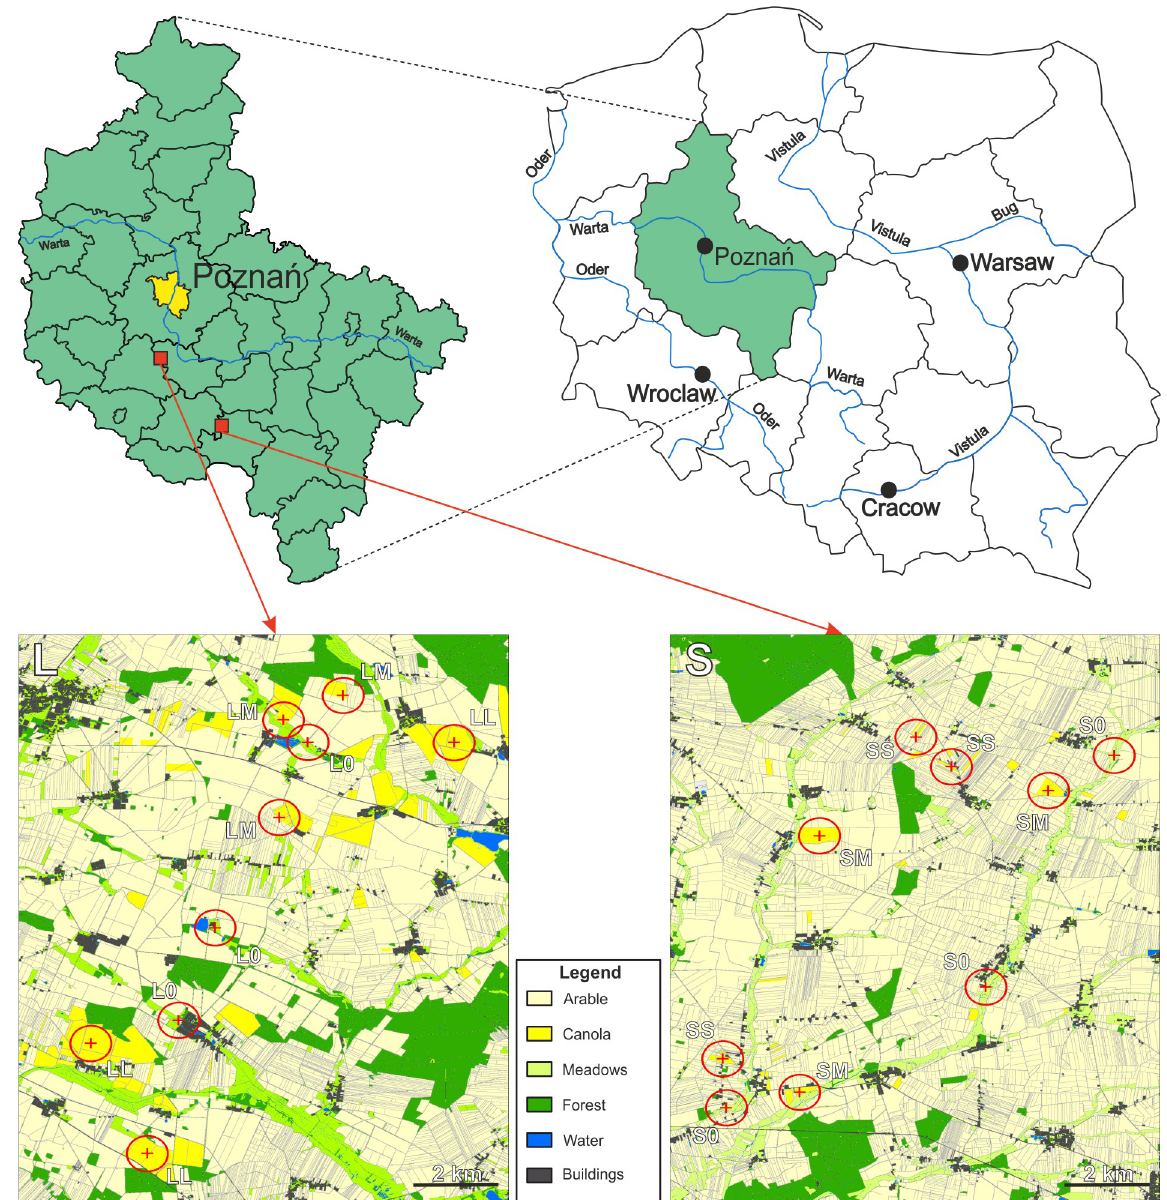
Fig 1. Location of the study landscapes and sites. Upper right, administrative division of Poland into provinces. In green–Wielkopolska province. Upper left–administrative division of Wielkopolska with the capital of the region [Pozna ń ] marked in yellow and the location of the two study landscapes (red squares; enlarged bellow) representing two contrasting landscape types: S–small-fields landscape, L–large-fields landscape. Within each landscape the locations of the study sites are marked (red circles– 500 m radius). The first character stands for landscape type (S vs. L); the second character stands for canola coverage: 0 –none, S–small (10–14%), M–medium (20–52%), L–large (80–98%). Land- cover maps were generated according to methodology described by Zio´łkowska et al. [33], see Methods section for more details. woodlands, water bodies) and pedo-climatic conditions, but differ in the farmland structure (Table 1). Raster land-cover maps (resolution of 1 m 2 ) for the landscapes were generated in a step-by- step process according to the methodology described in [33] by combining data from: (1) the National Database of Topographic Objects (BDOT) providing the land cover and land use